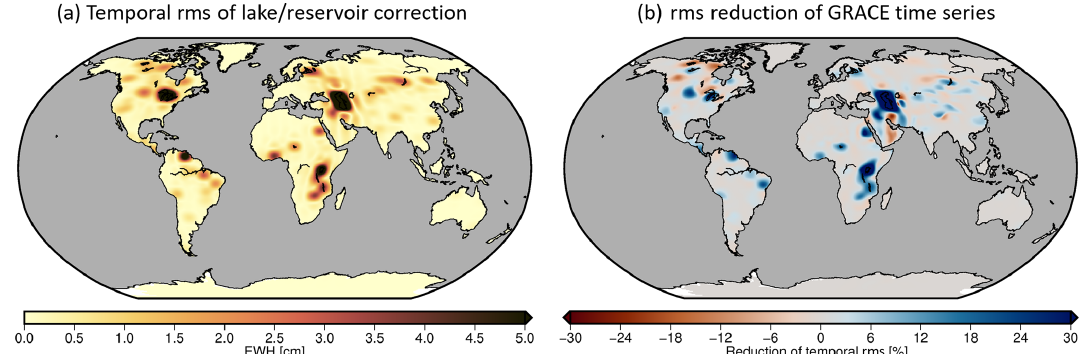
Figure 5. Temporal root mean square (rms) of the lake/reservoir correction time series for each grid cell (a) and the relative reduction in temporal rms when subtracting the correction (removal) from the original GRACE TWS time series (b) .